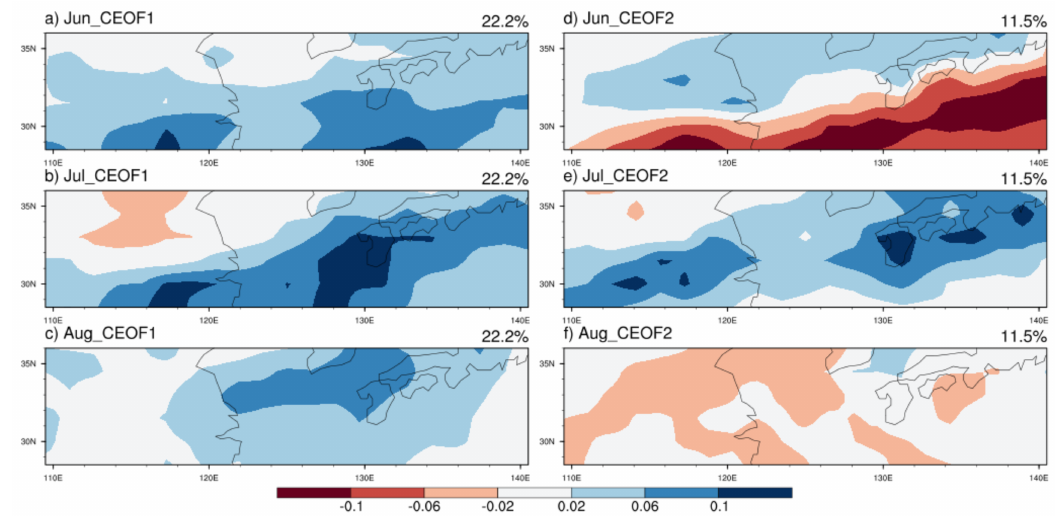
Figure 2. The spatial patterns for the first ( a – c ) and second ( d – f ) combined empirical orthogonal function (CEOF) modes of monthly precipitation anomalies in summer.